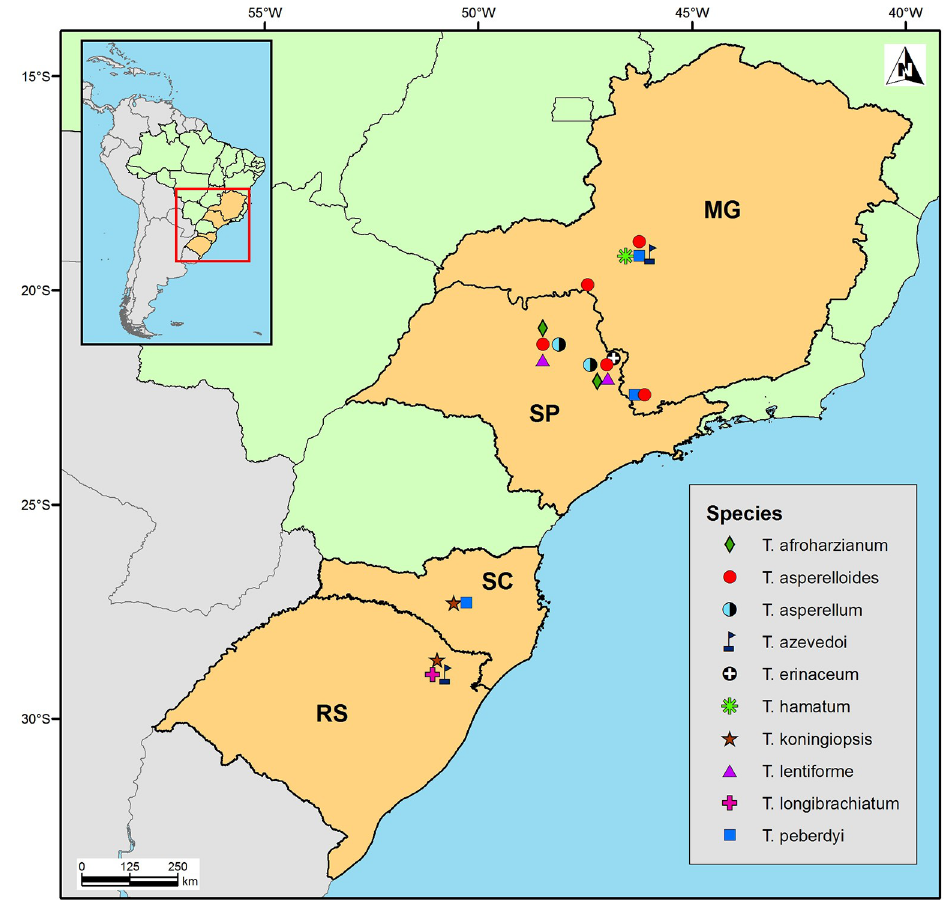
Fig 1. Map of Southeastern Brazil showing soil collection sites and recovered Trichoderma